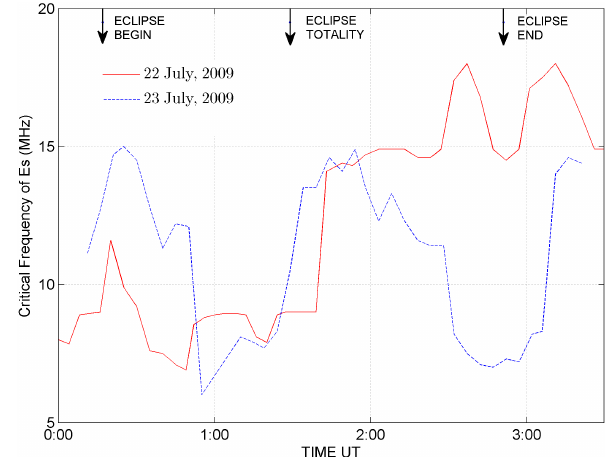
Fig. 1. Variation of f 0 Es during the total solar eclipse day of 22 July 2009 and the post-eclipse day of 23 July 2009 over